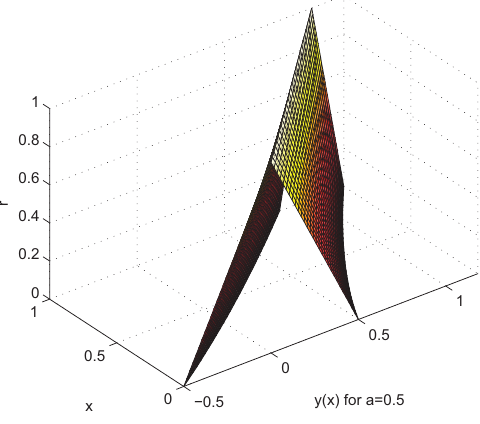
Figure 6. The solution of FDE under case 2